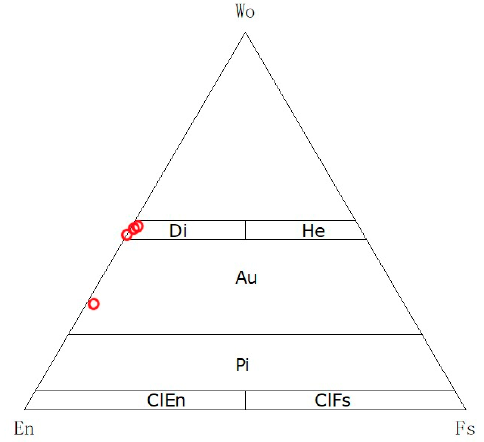
Figure 7. Classification graph of pyroxene in “Laoshan Jade” [37]: Wo—wollastonite; En—enstatite; Fs—ferrosilite; Di—diopside; He—hedenbergite; Au—augite; Pi—pigeonite; ClEn—clinoenstatite; ClFs—clinoferrosilite. Table 2. Formulas of pyroxene in “Laoshan Jade”.